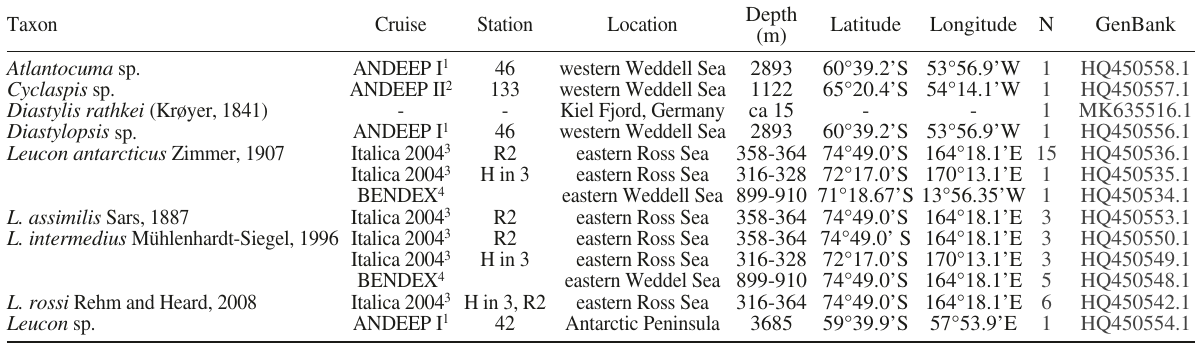
Table 1. – Cumacean sequence data for phylogenetic analysis and GenBank accession numbers; specimens used (N). The ANDEEP and BENDEX expeditions were carried out with RV Polarstern , 1 ANT-XIX/3, 2 ANT-XIX/4; 3 19th Italian Antarctic Expedition with RV Italica , 4 ANT